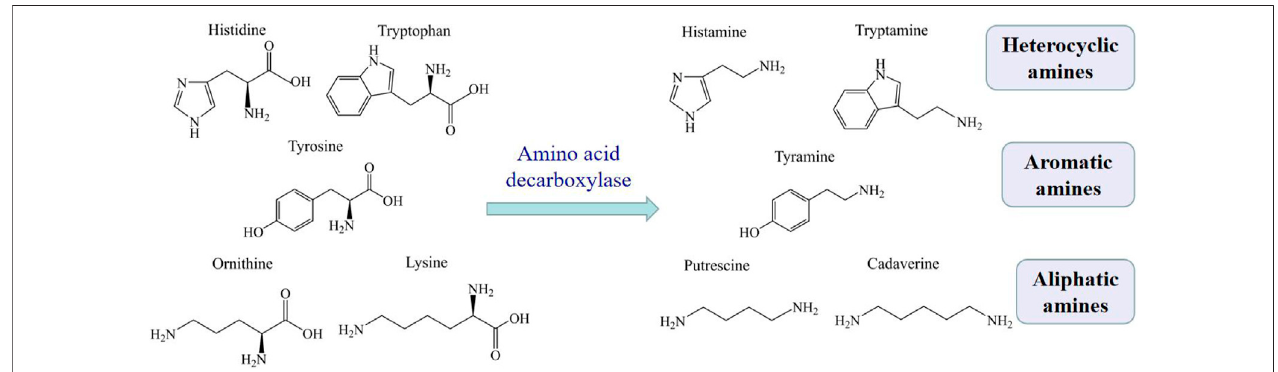
FIGURE 1 | The production of major BAs in aquatic